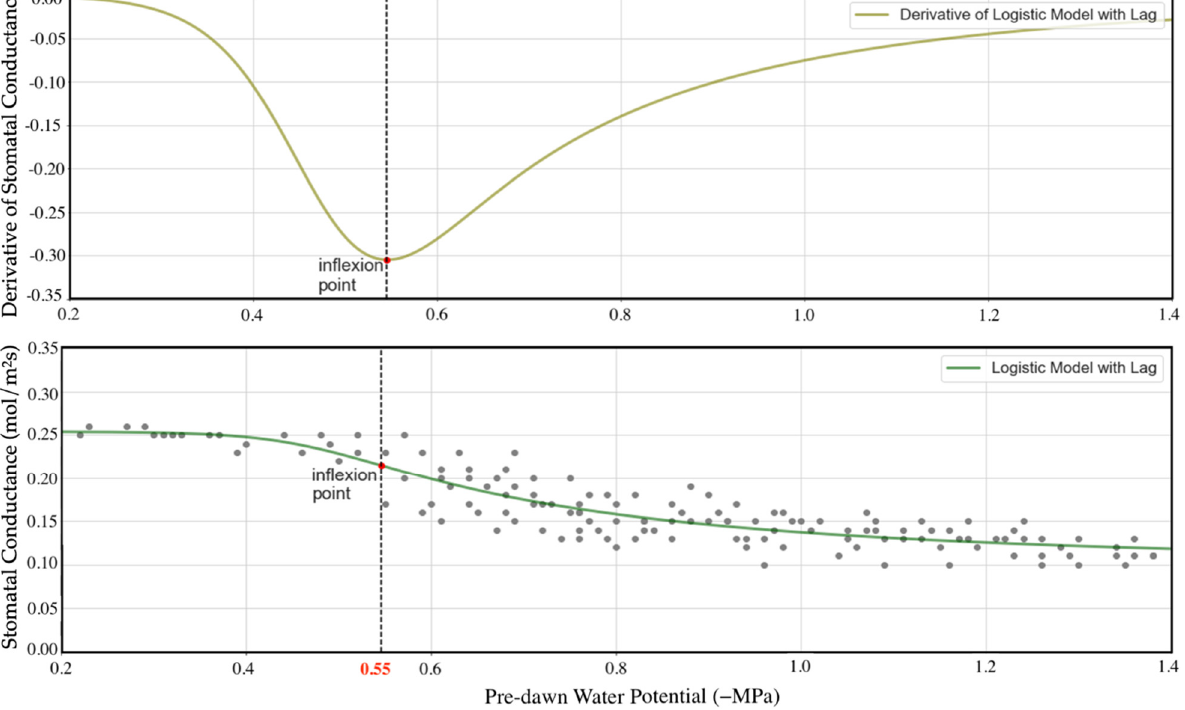
Figure 7. Identification of inflection point (“switch point”) of pre-dawn water potential (upper curve) and its correspondence to the set of data shown in previous Figures.